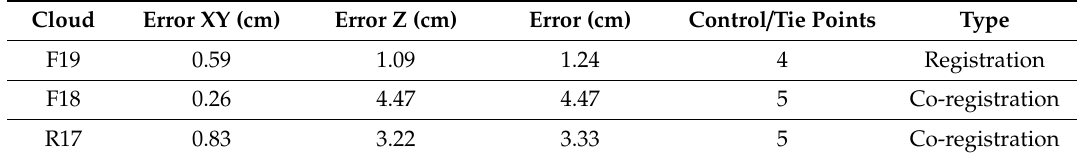
Table 2. Concerning R17, despite its lower number of images, provided 5,147,569 points with a Table 2. Registration/co-registration errors. comparable accuracy. Table 2. Registration / co-registration errors.